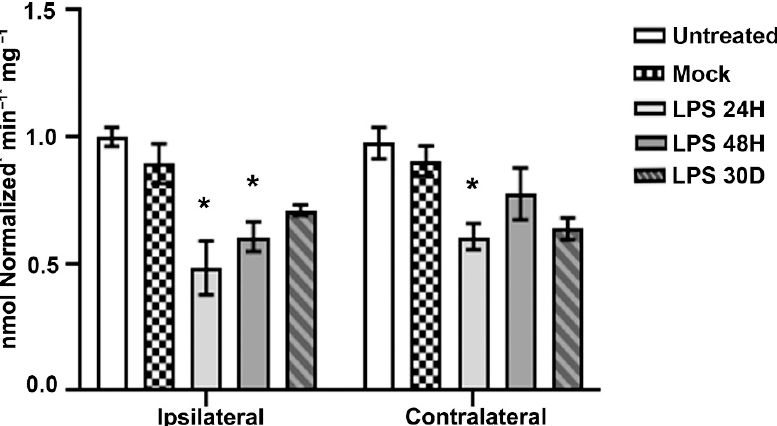
Figure 6. The intranigral LPS administration bilaterally decreases the mitochondrial complex I (CI) activity in homogenates of the entire substantia nigra. Data are expressed as the mean ± SEM ( n = 6 independent rats per time point and experimental condition). The asterisk (*) compares LPS groups with the Mock and Ut groups. Two-way ANOVA and post hoc Tukey tests, p < 0.05.